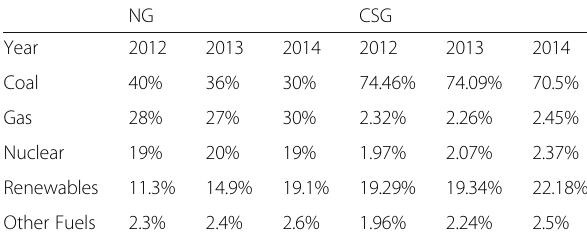
Table 2 Energy source used for electricity generation in NG and CSG